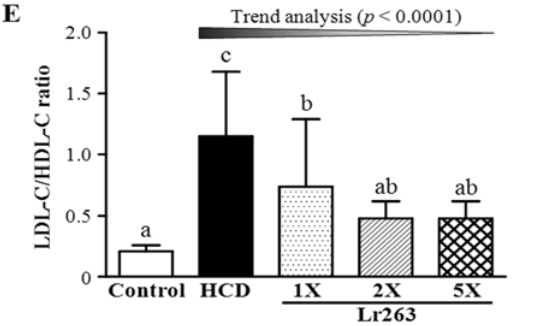
Figure 4. Effect of six-week supplementation with Lr263 on serum TC ( A ); TG ( B ); HDL-C ( C ); LDL-C ( D ) levels; and LDL-C/HDL-C ratio ( E ) in hyperlipidemic hamsters. Data are mean ± SD, n -8 hamsters in each group. Columns with different letters (a, b, c) differ significantly at p < 0.05 by a one-way ANOVA.